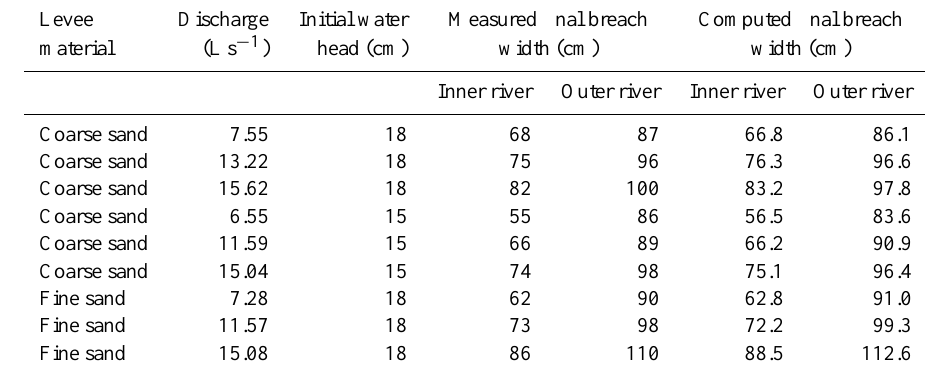
112.6 Fig. 3. Sketch of the experiment layout.